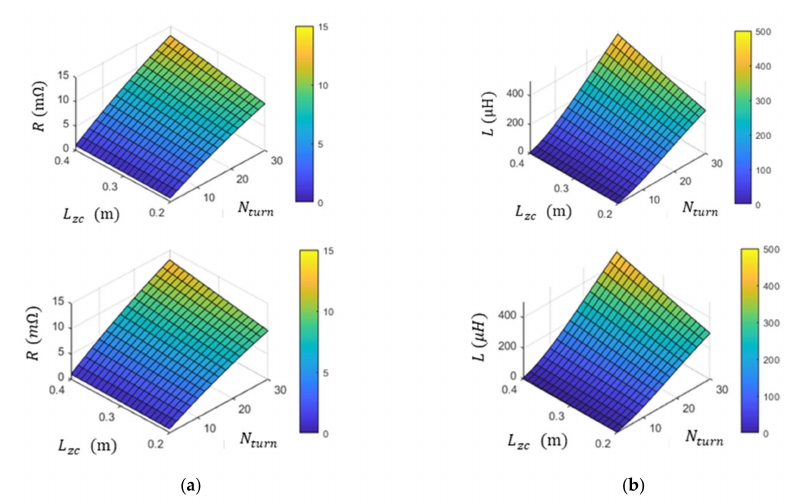
Figure 12. Resistance and inductance of τ c = ( 2/3 ) τ SCM for di ff erent L zc and N turn calculated using the approximated equations: ( a ) resistance and ( b )